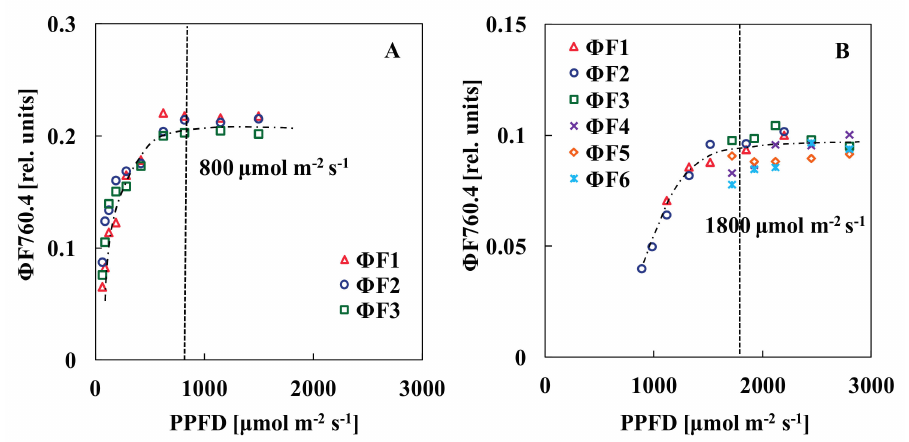
Figure 3. Relationships between light pulse PPFD and ChlF yield ( Φ F: near 760.4 nm) of paprika leaves. ( A ) results in the dark-adapted leaf (SPAD value of 47.5, measured by SPAD-502, Soil and Plant Analyzer Development, Konica Minolta, Tokyo, Japan) measured three times ( Φ F1 to Φ F3); ( B ) results in the light-adapted leaf (SPAD value of 42.6) measured twice ( Φ F1 and Φ F2) at solar PPFD of 700 µ mol m − 2 s − 1 and four times ( Φ F3 to Φ F6) at 1300 µ mol m − 2 s − 1 . The JUNIOR PAM actinic light system was used as the light pulse source. Dashed lines represent the minimal PPFD for the saturation light